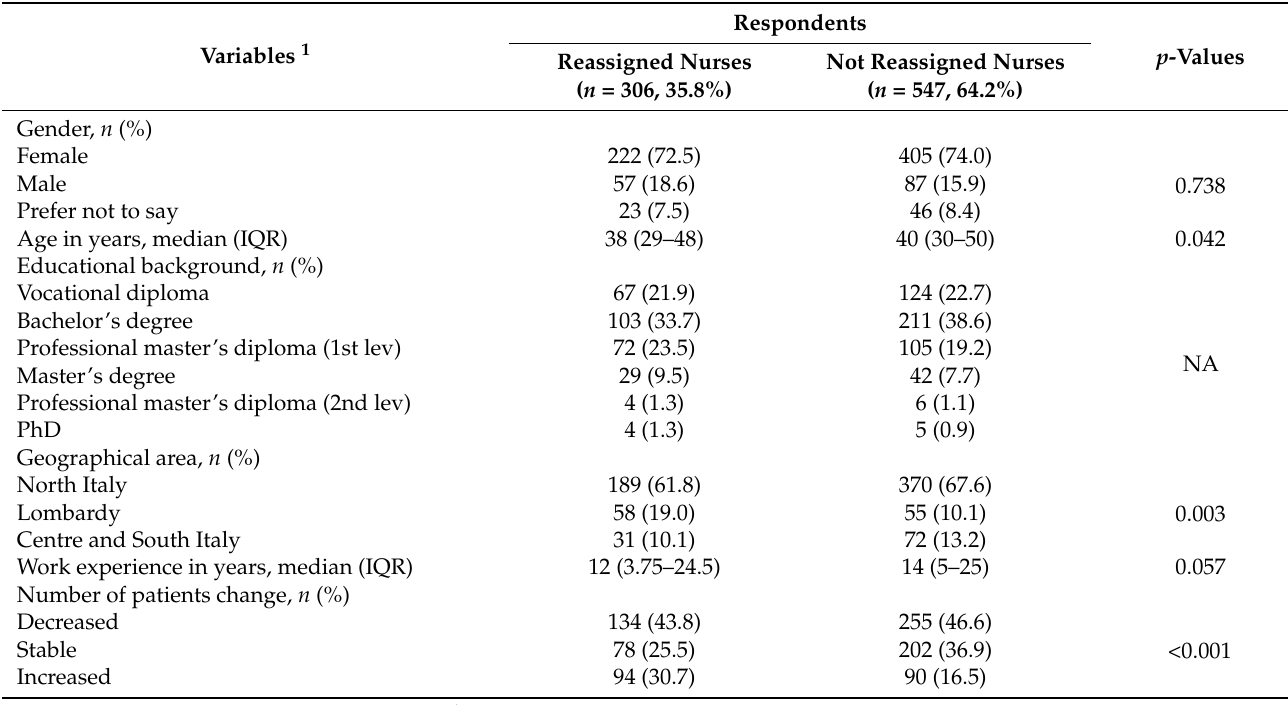
Table 2. Differences between nurses who changed their work